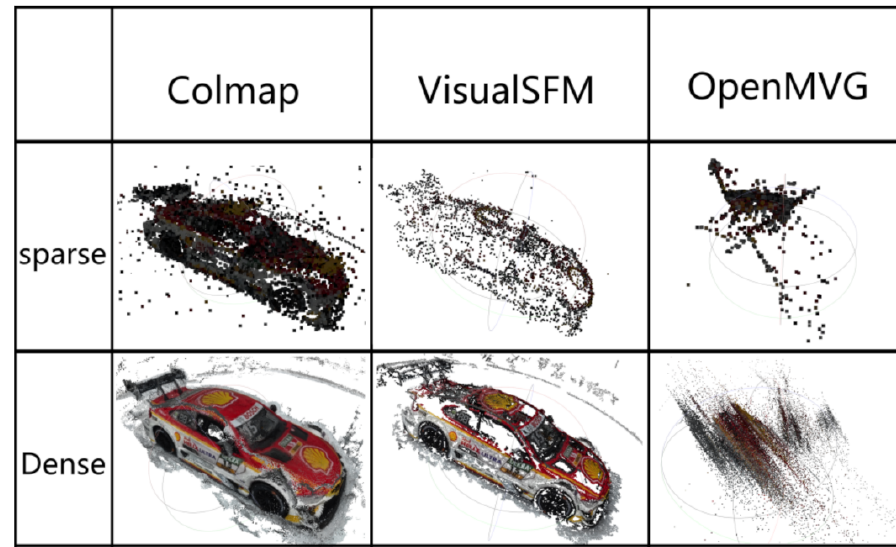
Figure 21. The results of experiment 3.